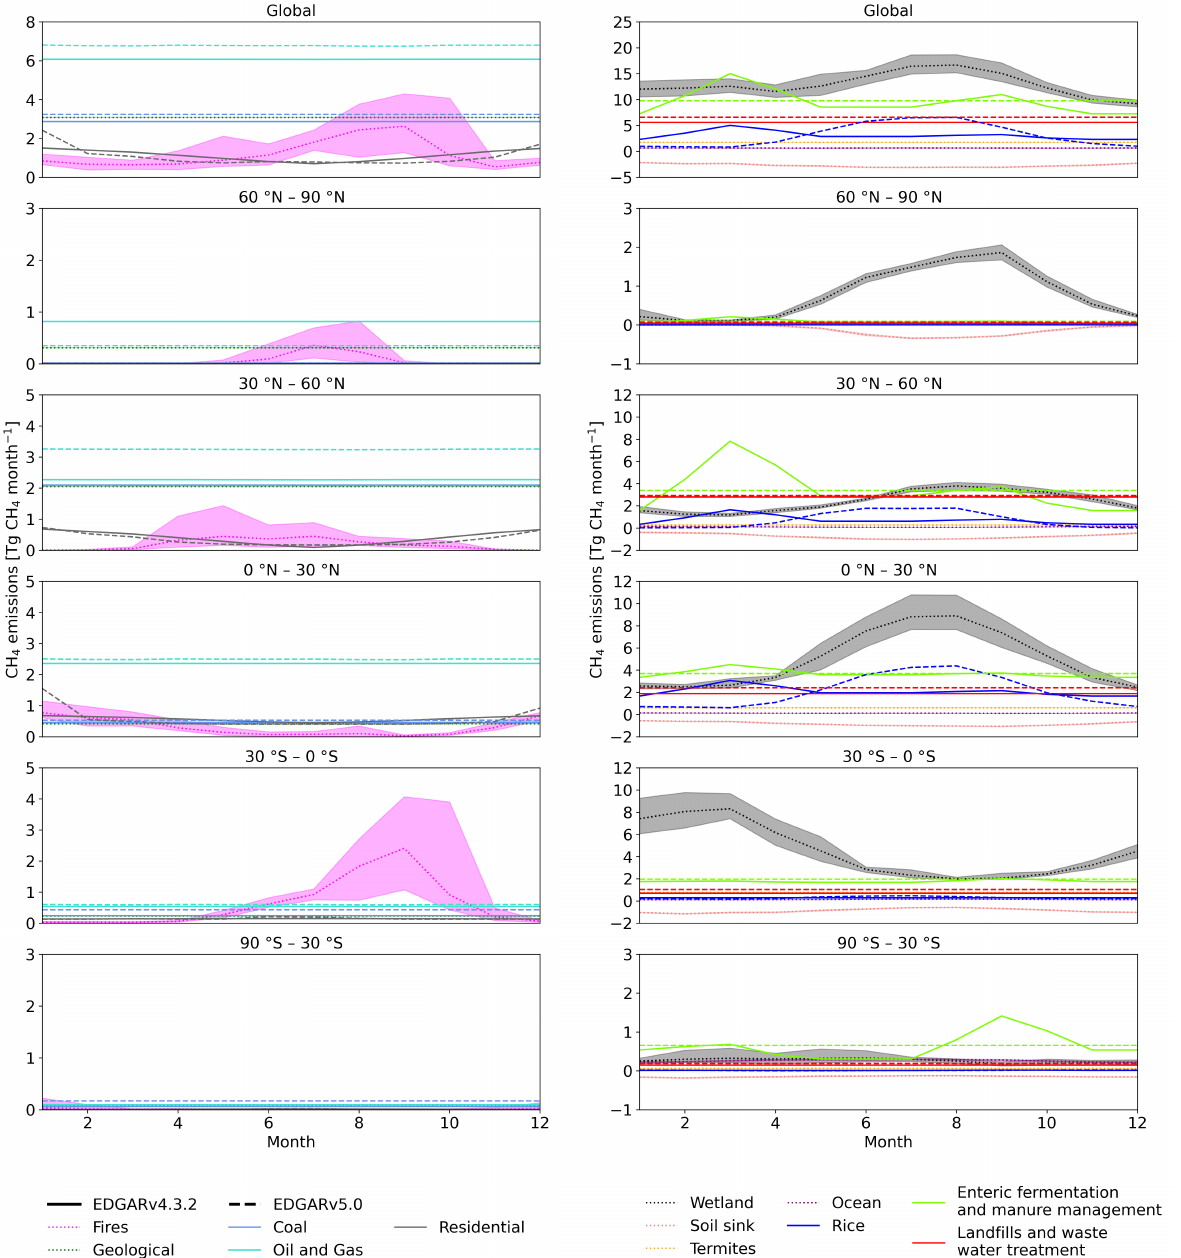
Figure 1. Monthly emission estimates for global (top) and latitudinal zonal totals. The left-hand-side panel includes fossil-based emissions, and the right-hand-side panel includes emissions of biogenic origin, both natural and anthropogenic. Global emissions (top) are split into 30° latitude bands. Emissions from EDGAR v4.3.2 are for the year 2010 and from EDGAR v5.0 for 2015. Natural sources are averages for 2000–2012. Shaded areas show the minimum and maximum of the monthly totals over 2000–2012. Solid lines are EDGAR v4.3.2, dashed lines are EDGAR v5.0, and dotted lines are other